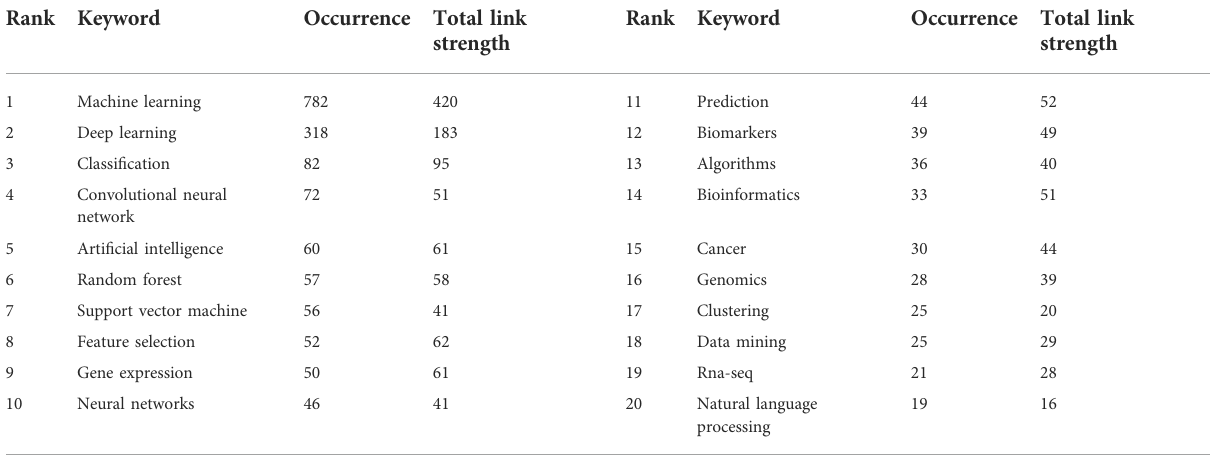
TABLE 3 Highly link strength of the top 20 occurrence